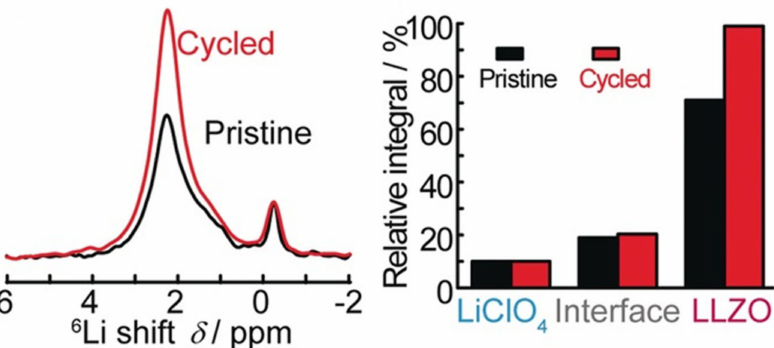
Figure 21. 6 Li foil cycling experiment performed on a PEO-LiTFSI system containing LLZO (14.1 T, 25 kHz MAS). Reprinted with permission from [113]. Copyright 2014 Wiley and